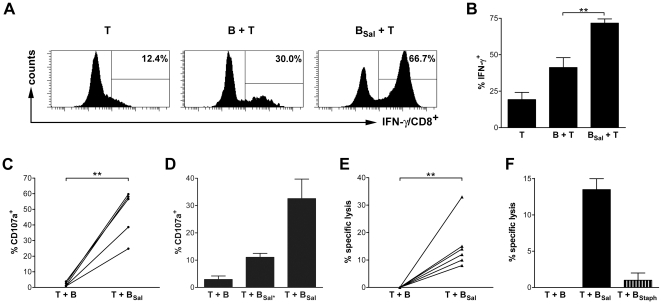

Salmonella-infected B cells induce Salmonella-specific CD8+ T cells to secrete IFN-γ and are cytotoxic.(A) CD4+ and CD8+ T cells were cultured alone (T), with B cells (B + T) or with anti-IgM-coated Salmonella-infected B cells (BSal + T). After 11 days, CD8+ T cells were stimulated for 5 hours with PMA, ionomycin and BFA and analyzed for IFN-γ production by intracellular FACS staining. A representative experiment of five independent experiments using cells from different healthy donors is shown. (B) Salmonella-infected B cells induce IFN-γ-expression by CD8+ T cells compared to non-infected B cells. Data are the mean ± SEM from five independent experiments of different donors and ** p<0.01. (C) CD8+ T cells were primed with coated Salmonella-infected B cells and the proliferating CD8+ T cells were sorted after 6 days, expanded with IL-2 for another 6 days and restimulated with autologous B cells that had either or not phagocytosed Salmonella. Salmonella-specific degranulation was measured by CD107a expression at the plasma membrane CD8+ T cells. Data are means ± SEM of five independent experiments of different donors, and ** p<0.01. (D) Proliferating CD8+ T cells primed with B cells that had naturally phagocytosed Salmonella were sorted and CD107a expression was measured upon re-encounter of B cells (T + B), B cells naturally infected with Salmonella (T + BSal*) or anti-IgM-coated Salmonella (T + BSal). Data are of two experiments. (E) Sorted Salmonella-primed CD8+ T cells (see C) specifically kill Salmonella-infected B cells as measured by 51Cr release of autologous B cells that were either or not infected with Salmonella. Data are expressed as mean ± SEM, of six independent experiments of different donors, and ** p<0.01. (F) Sorted Salmonella-primed CD8+ T cells (see C) do not kill Staphylococci-infected B cells as measured by 51Cr release of autologous B cells that were either infected with Salmonella or with Staphylococci. The data are expressed as mean ± SEM, of two independent experiments of different donors.